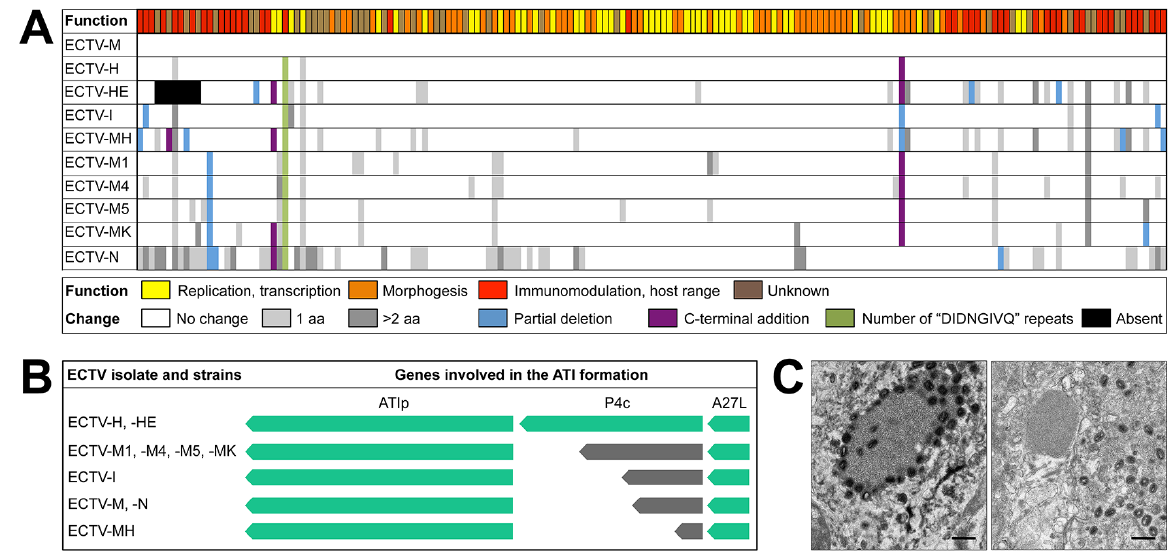
Figure 5. Variability among the proteins encoded by the genomes of the ECTV isolates and strains. ( A ) Comparison of the protein content: each rectangle represents a protein with aa changes (due to non-synonymous nt mutations) when compared to that of the reference ECTV-M. The color of the upper row rectangles indicates the function of each protein (Function) and the lower row indicates the type of modification (Change). Non-synonymous nt mutations that cause termination of the reading frame are indicated by the light blue color (partial deletion). ( B ) ECTV genes involved in ATI bodies morphogenesis and virion inclusion process: genes are shown in green and pseudogenes in grey. ( C ) Electronic micrographs of spleens of mice infected with 10 3 pfu per mice of ECTV-H, (left), and ECTV-M, (right), at 4 dpi.